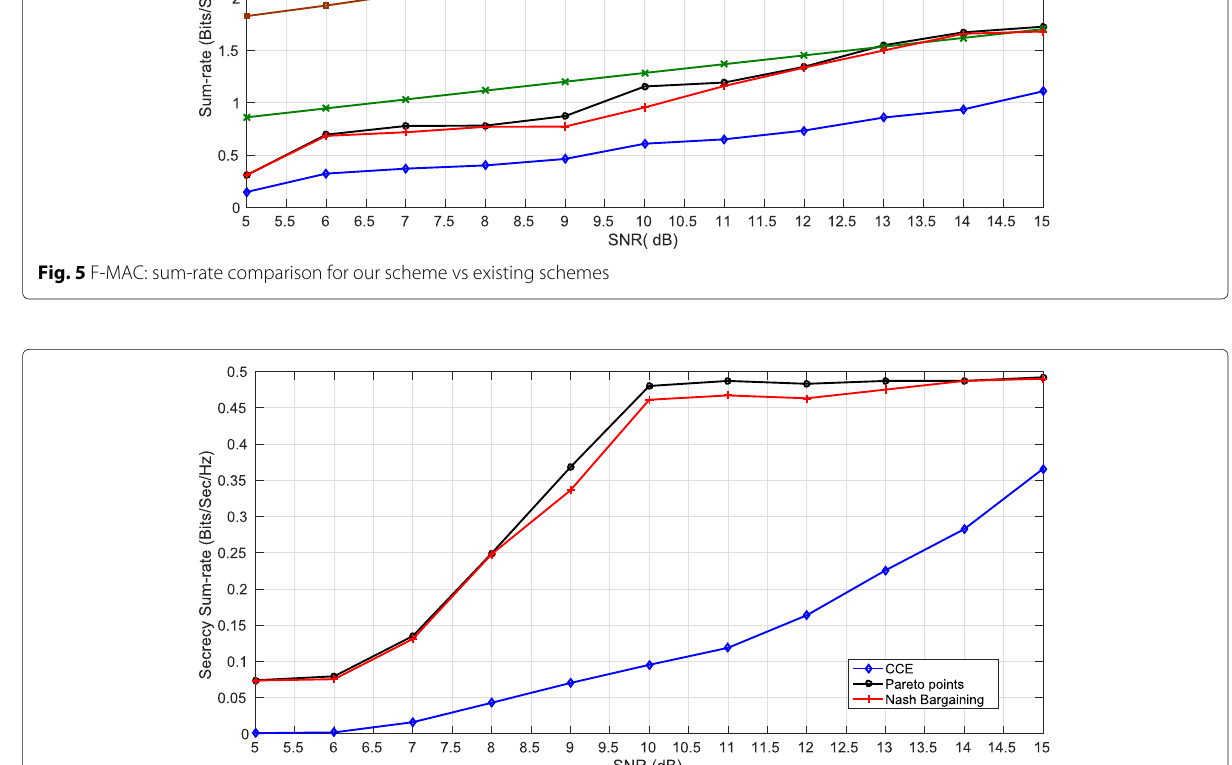
Fig. 6 Sum rate with security constraints: comparison of CCE, PP and NBS at fixed transmission rate (with CSI of Eve)